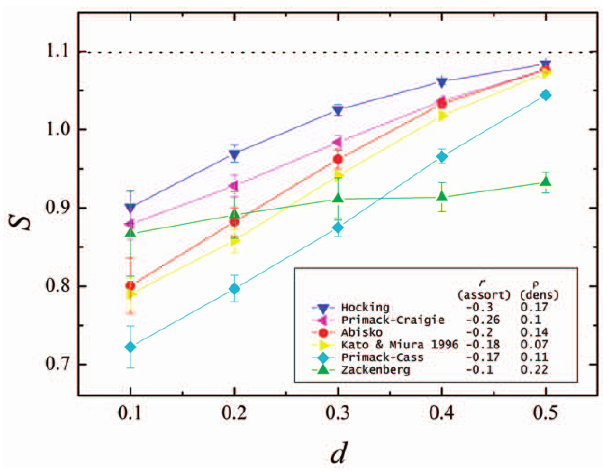
Figure 8. Entropies of the distribution of extincts vs. habitat destruction in natural networks. Several networks reported in [22] are shown, together with the values of their characteristic parameters after the transient (as explained in the section Dynamical model of the mutualistic system). Besides those already mentioned there are those marked with letters in Fig. 3: a) Hocking (arctic), b) Primack-Craigie (temperate), c) Kato & Miura 1996 (temperate), d) Primack-Cass (temperate). The dashed line near the top represents the maximum